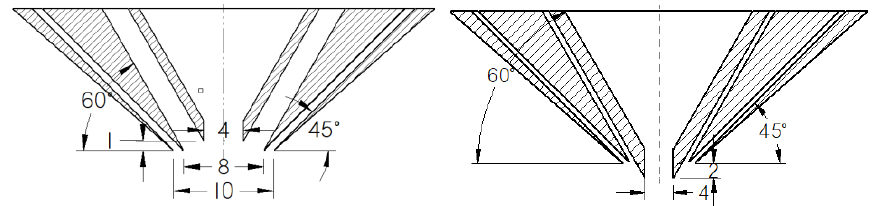
Figure 1: A. inward